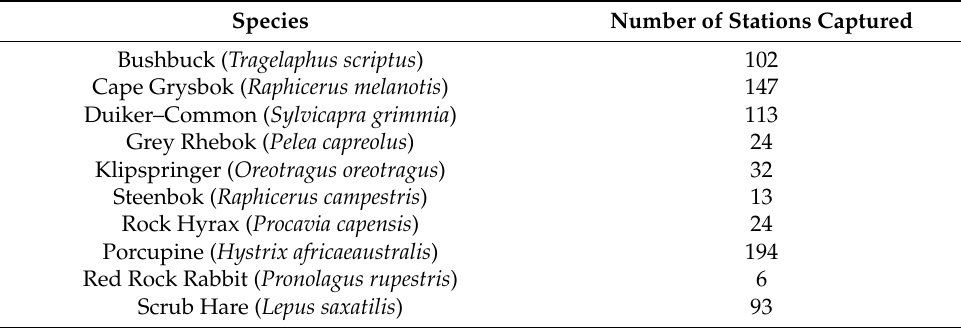
Figure A1. Location of 258 camera traps used to predict potential prey species distribution model. Table A1. Number of prey species used to predict prey distribution and the number of locations each species was